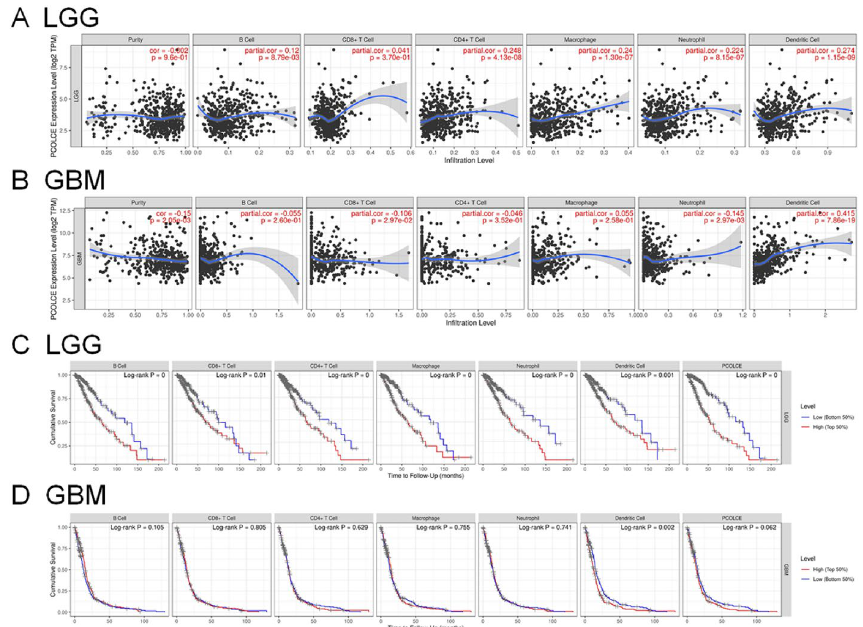
Figure 9. The relationship between PCOLCE expression level, tumor purity, and immune cell infiltration was explored using the TIMER database. PCOLCE was significantly correlated with immune cell infiltration in ( A ) LGG and ( B ) GBM patients. Kaplan–Meier survival analysis of several immune cells in ( C ) LGG and ( D ) GBM